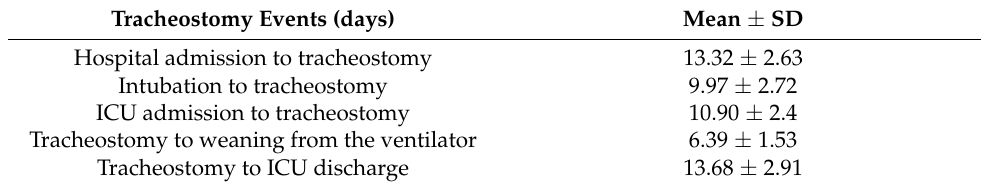
Table 2. The timing of the tracheostomy